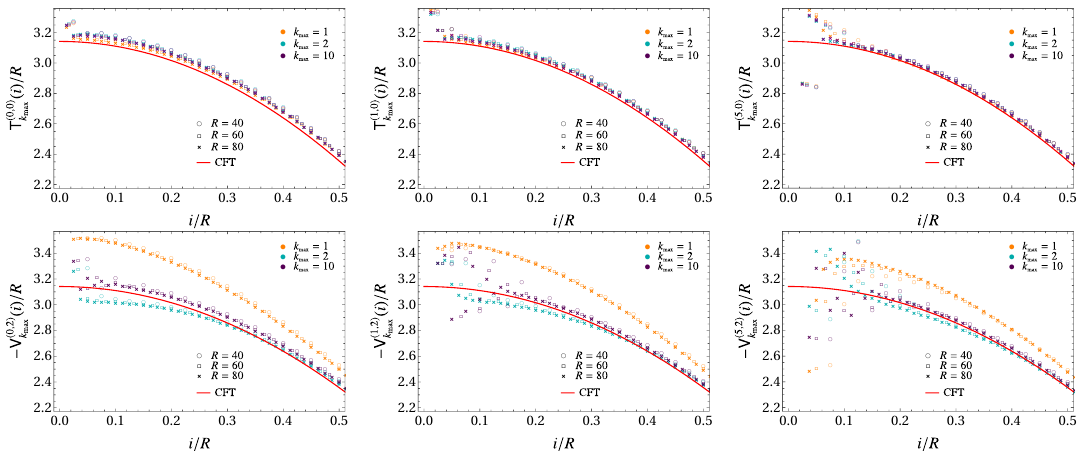
Figure 14. Combinations (3.14) and (3.21) when ω = 0 in the case of d = 3 , for various k These panels should be compared with the right panels of figure